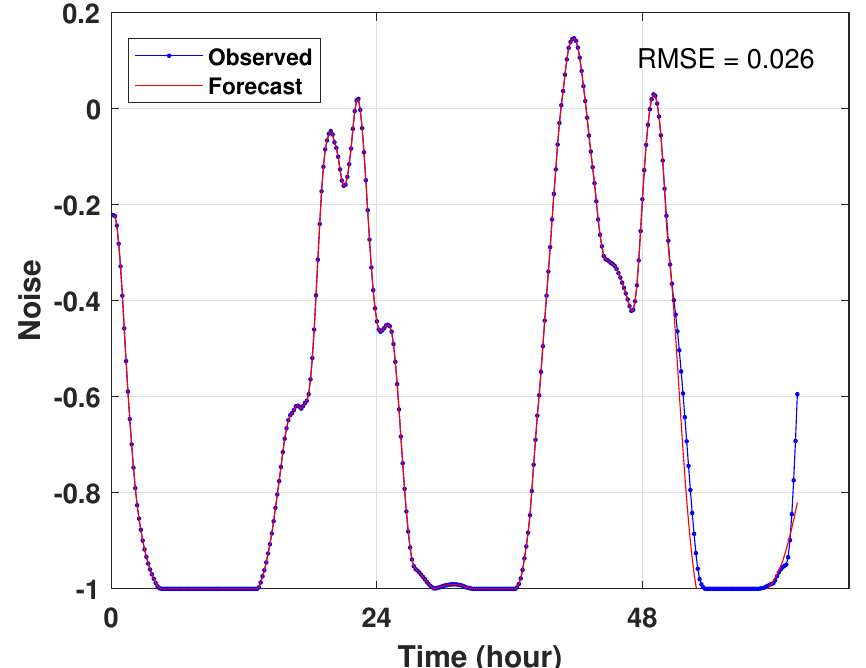
Figure 14. Noise forecasting by